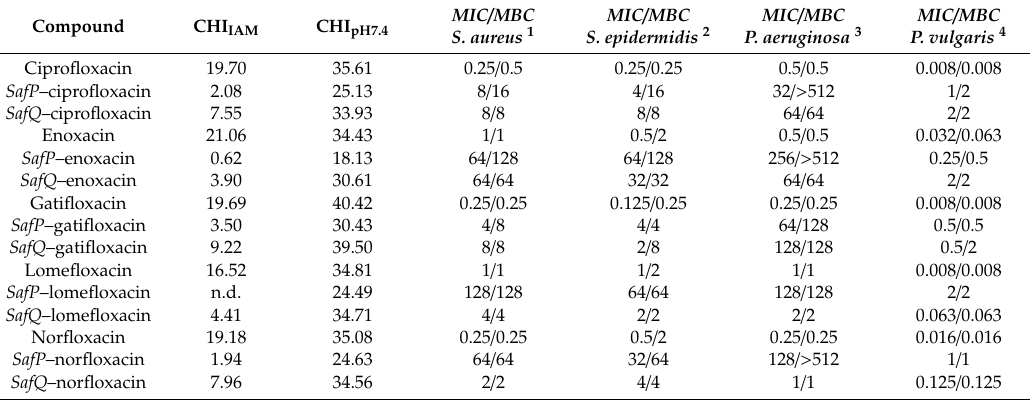
*—the data assessed in our previously study [7]; n.d.—not detected; CHI IAM —chromatographic hydrophobicity indices determined with IAM-HPLC; CHI pH7.4 —chromatographic hydrophobicity indices determined with